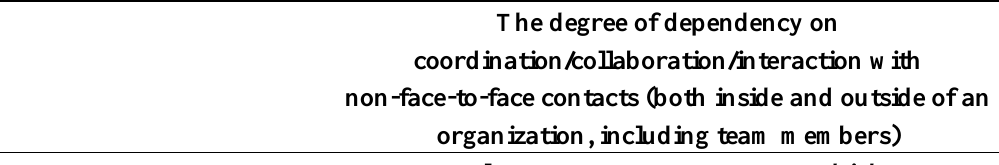
Table 1. Two-dimensional framework of